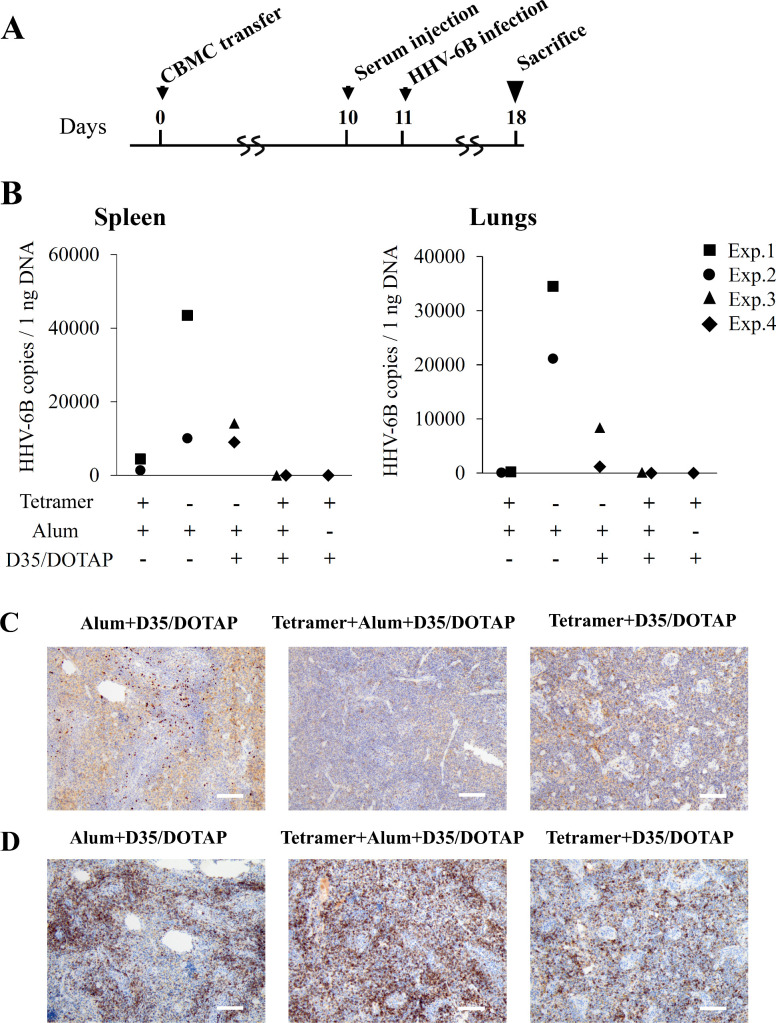
Humoral immunity induced by the vaccination prevented HHV-6B infection in vivo.(A) HHV-6B infection model was prepared by transferring human cord blood mononuclear cells (CBMCs) into humanized mice. After confirming the increase of human T cells, mice were pre-injected with the different kinds of sera. Sera from tetramer-immunized mice including tetramer+Alum, tetramer+Alum+D35/DOTAP or tetramer+D35/DOTAP, were used for the pre-injection. The sera from mice immunized with adjuvants only (Alum or Alum+D35/DOTAP) were also used as control. One humanized mouse was used for each group. Cell-free HHV-6B was infected intravenously into the mice, and the 50% tissue culture infective doses [TCID50]/ml of the HHV-6B in each experiment was as follows: Exp. 1: 1.4 × 105; Exp. 2: 6.7 × 104; Exp. 3: 9.6 × 104; Exp. 4: 9.6 × 104. HHV-6B-infected animals were euthanized at 7 days post-infection and the organs were collected for further analysis. (B) HHV-6B genome copies in the spleens and lungs were detected by quantitative PCR. Each of experiment 1–4 (Exp.1-4) indicated the experiment performed at the same infection timing. The expression of HHV-6B IE1 (C) and the infiltration of human CD3+ T cells (D) were detected by immunostaining of the spleen sections and shown as the representative photographs. Bar: 100 μm.